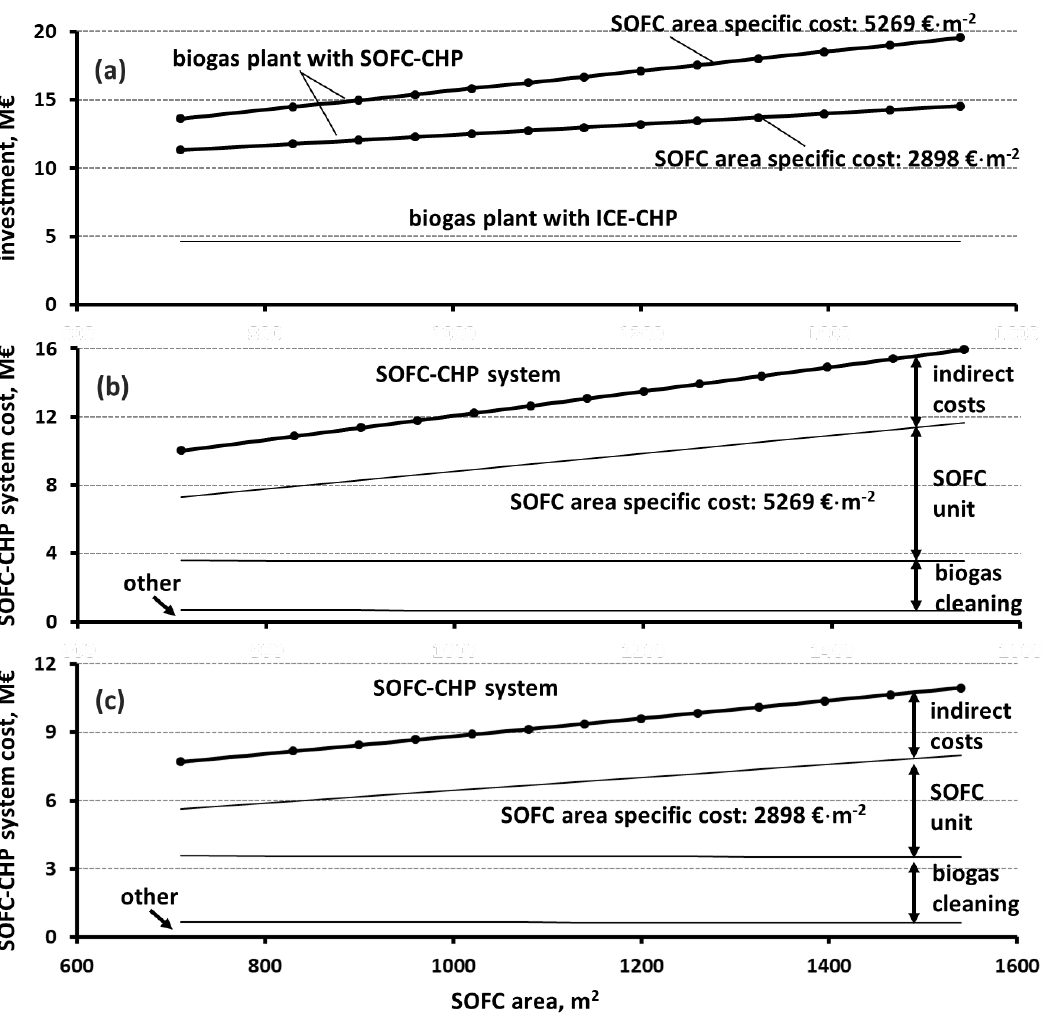
Figure 6. Initial investment of: ( a ) the conventional biogas-CHP plant with ICE-CHP, for 750 m 3 · h − 1 biogas production capacity, and of the corresponding SOFC-CHP system, for ( b ) 2898 EUR · m − 2 SOFC area specific cost and ( c ) 5269 EUR · m − 2 SOFC area specific cost.